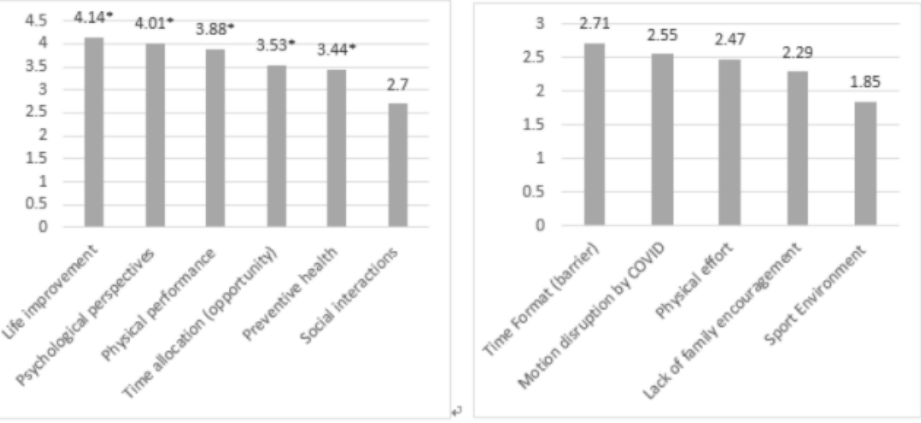
Figure 4. Mean scores of benefits and barriers (5-point Likert Scale). * = significantly higher score than the neutral value of